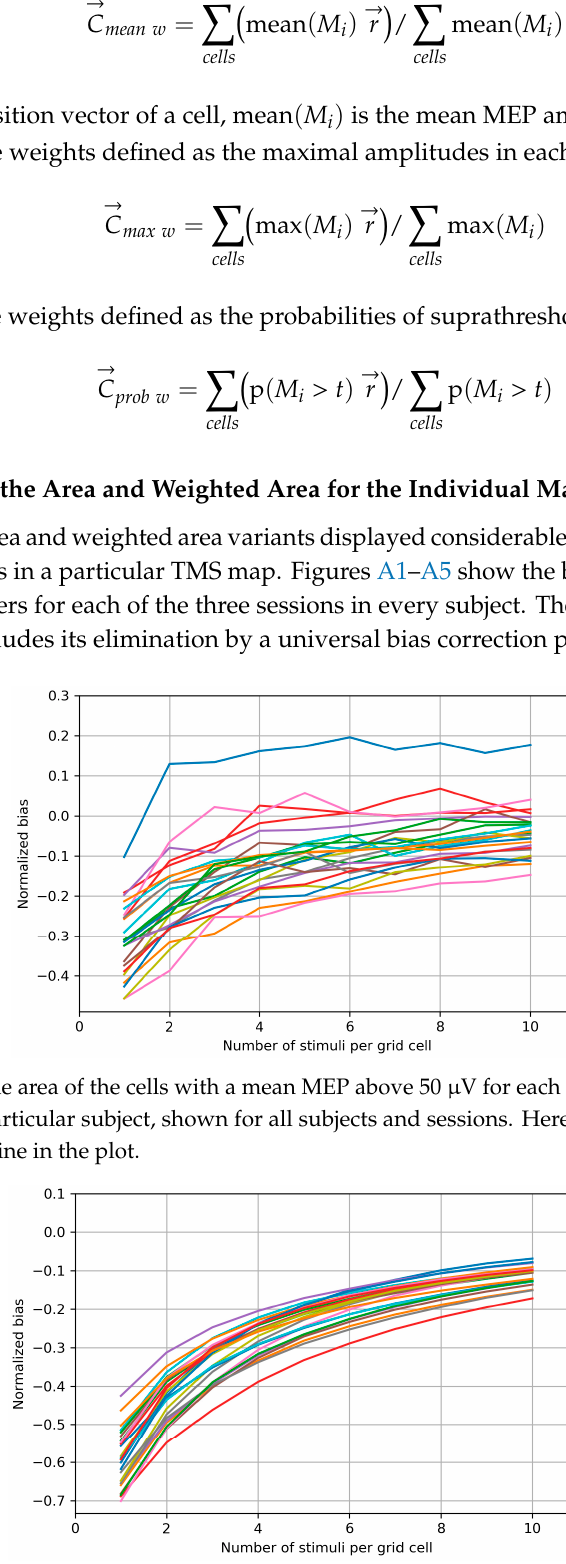
Figure A2. Bias of the area of the cells with the maximum MEP above 50 µ V for all sessions of all subjects.